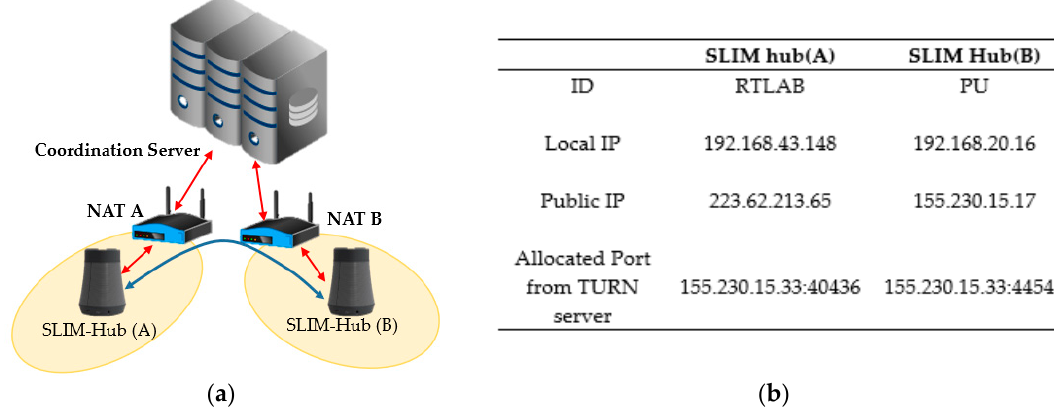
Figure 21. Connectivity environments of different NATs. ( a ) Configuration of experiments; ( b ) A list of SLIM hub’s ID and IP information.